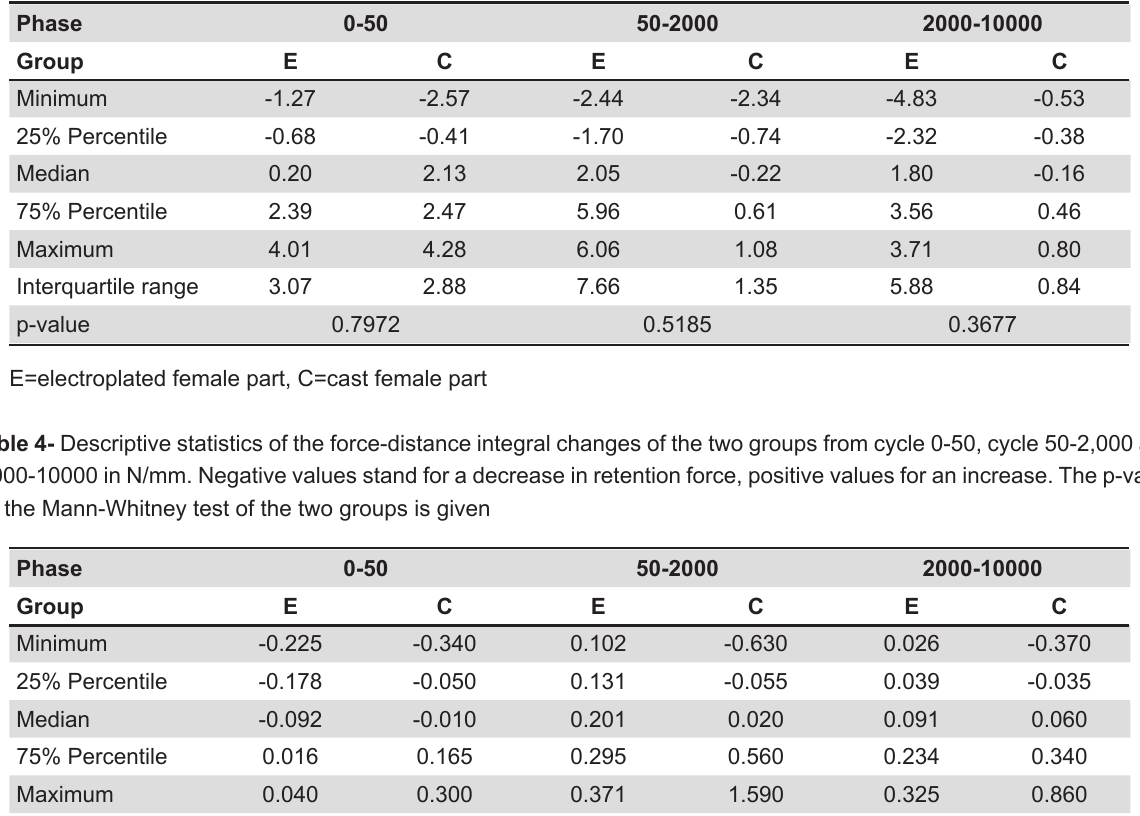
Table 3- Descriptive statistics of the retention force changes of the two groups from cycle 0-50, cycle 50-2,000 and 2,000- 10,000 in N. Negative values stand for a decrease in retention force, positive values for an increase. The p-value for the Mann-Whitney test of the two groups is given